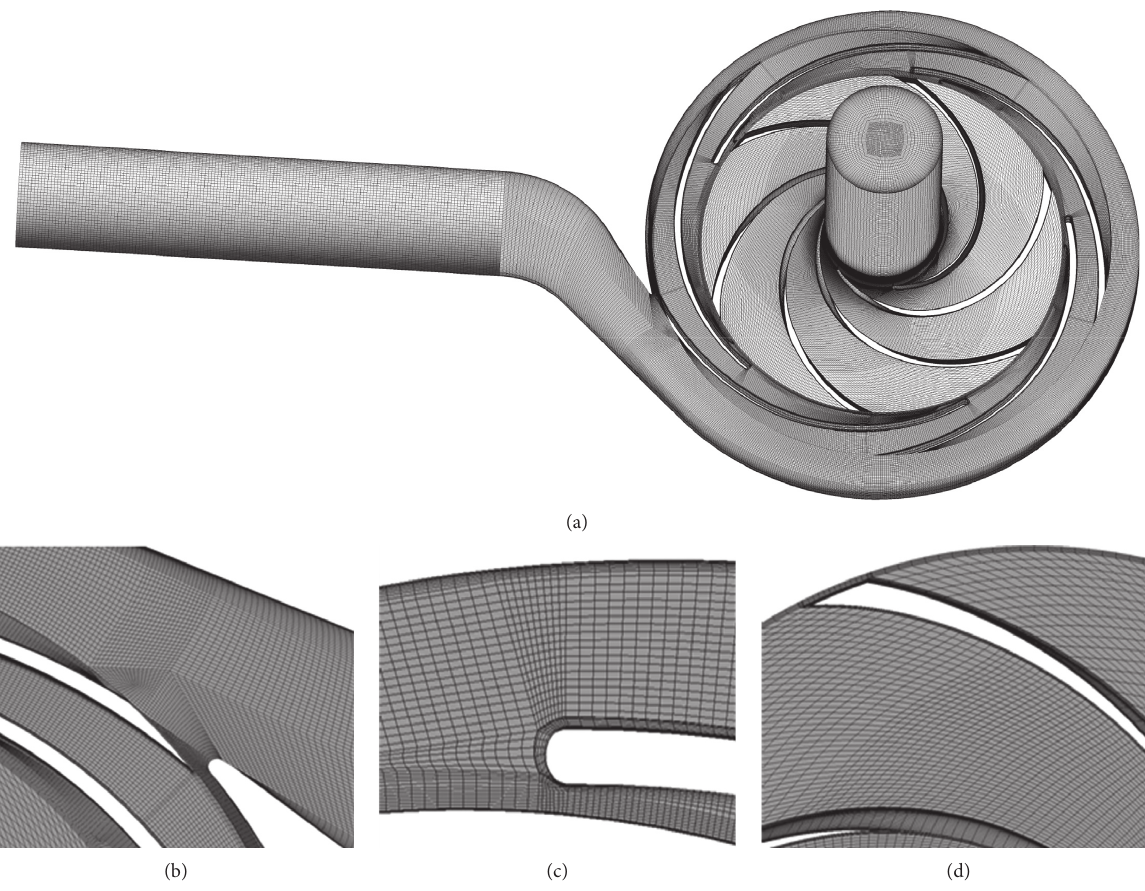
Figure 1: Computational domain of the PAT